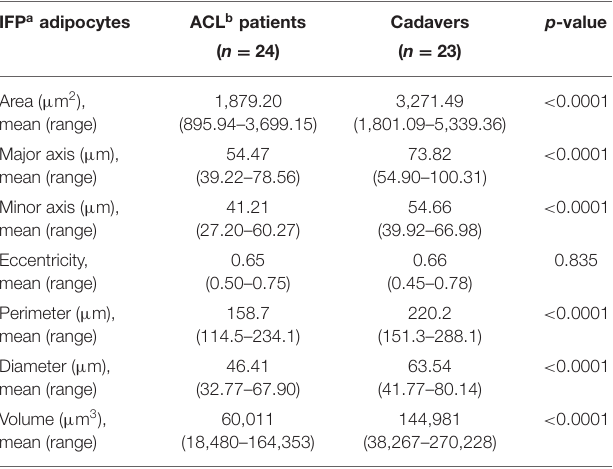
TABLE 2 | Infrapatellar fat pad adipocytes morphometric